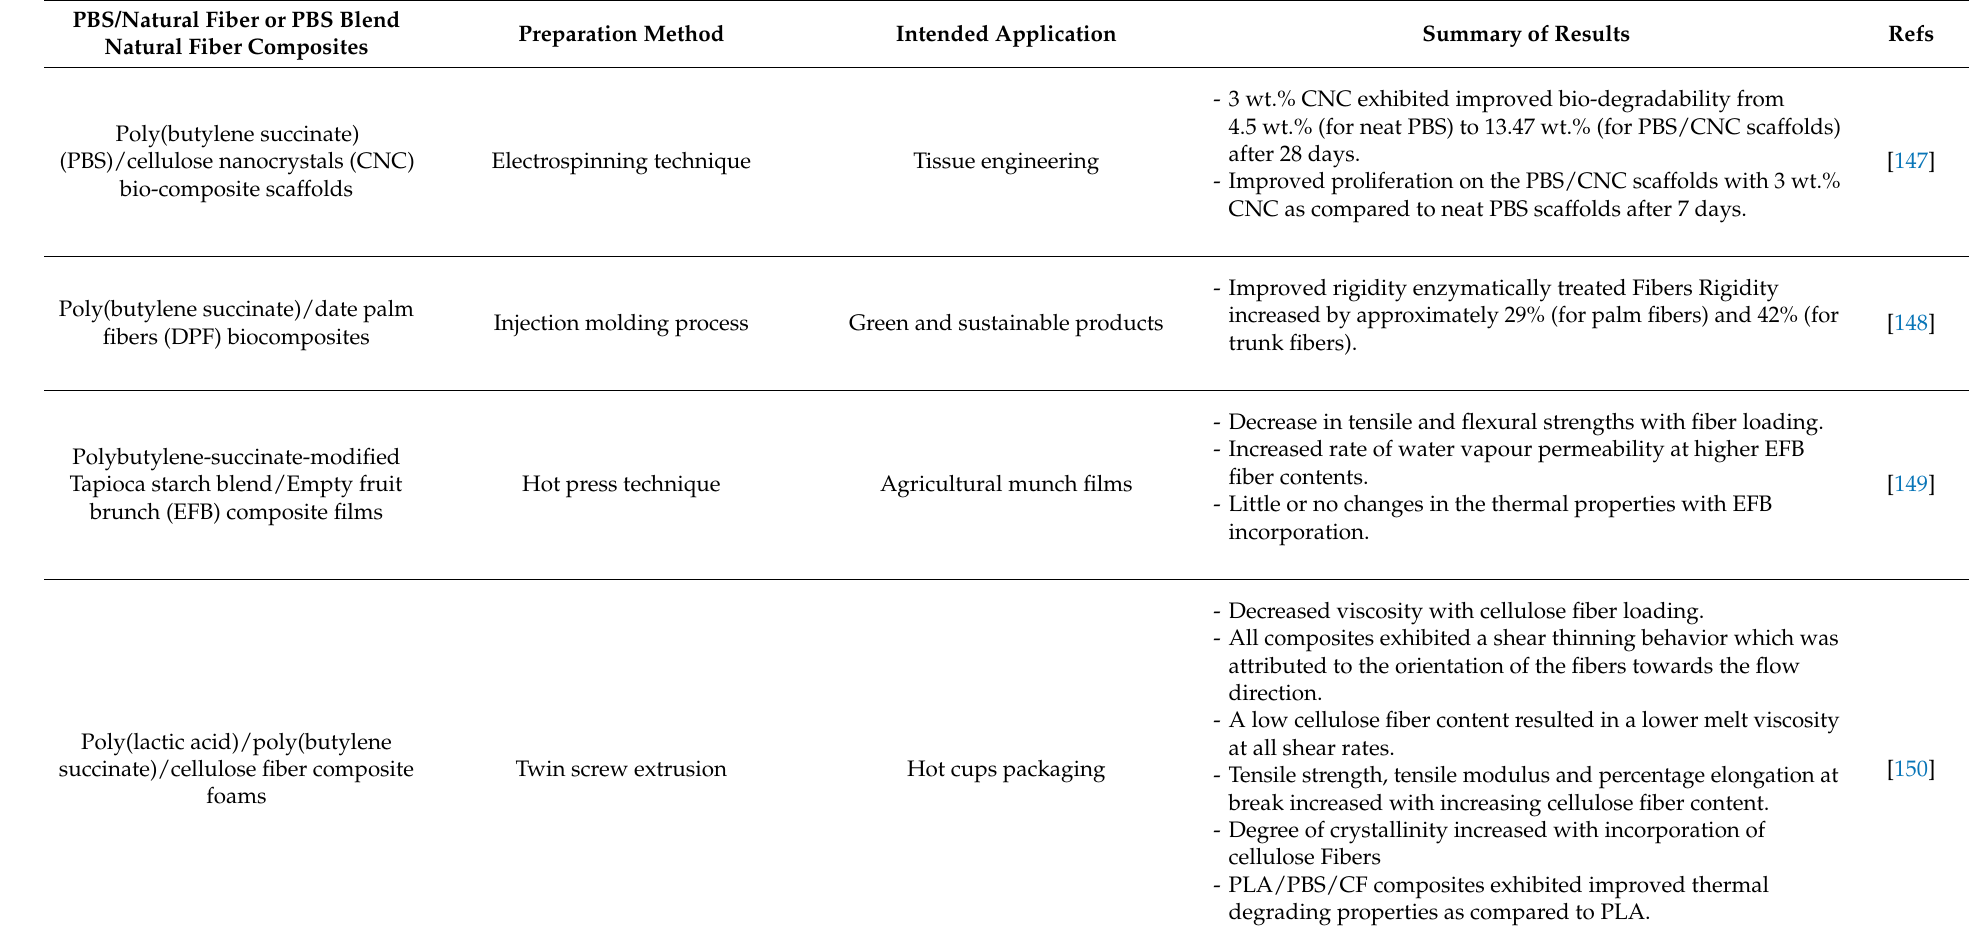
Table 6. Specific applications of different PBS/natural fibers composites and natural fiber PBS blend